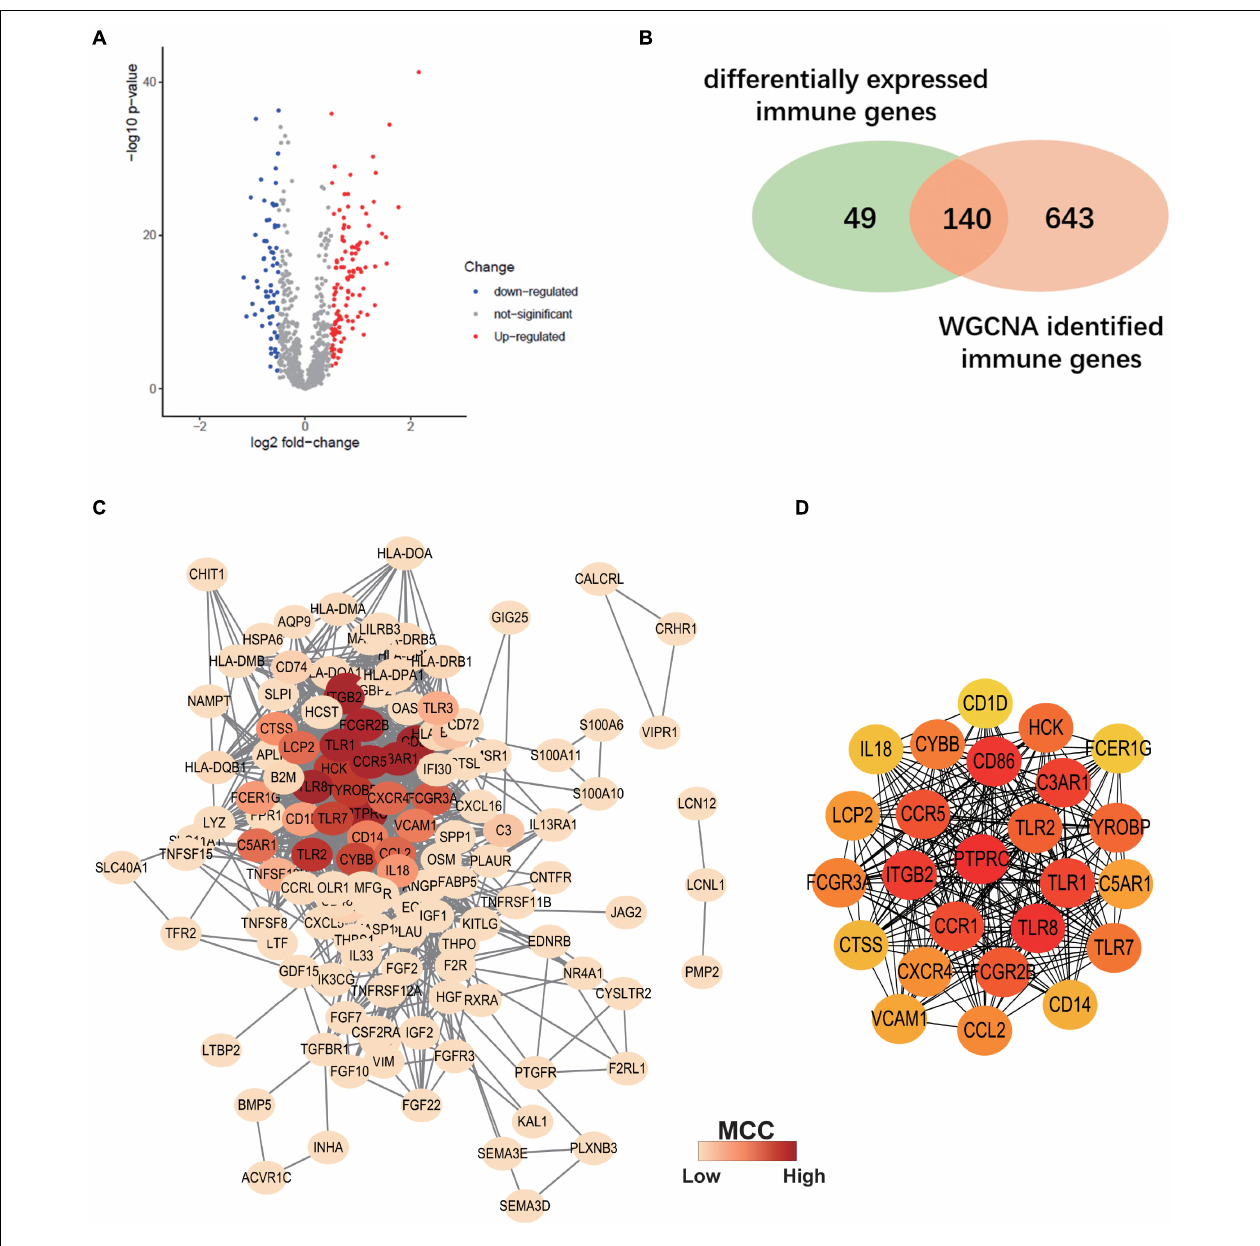
FIGURE 5 | Construction of Protein-protein interaction (PPI) Network. (A) Volcano plot of differentially expressed immune-related genes (IRGs) between ALS patients and non-neurological control subjects. Blue dots represent down-regulated genes (66 genes), red dots represent upregulated genes (123 genes), and gray dots represent no significantly differentially expressed genes. (B) Venn diagram of overlapping differentially expressed IRGs and ALS-related IRGs derived from WGCNA. (C) The PPI network consists of 130 nodes and 1066 edges. Color represents the degree of Maximal Clique Centrality (MCC) calculated by Cytohubba. Red indicates nodes with high MCC score. (D) Twenty-five genes with the highest MCC score in this PPI network and their